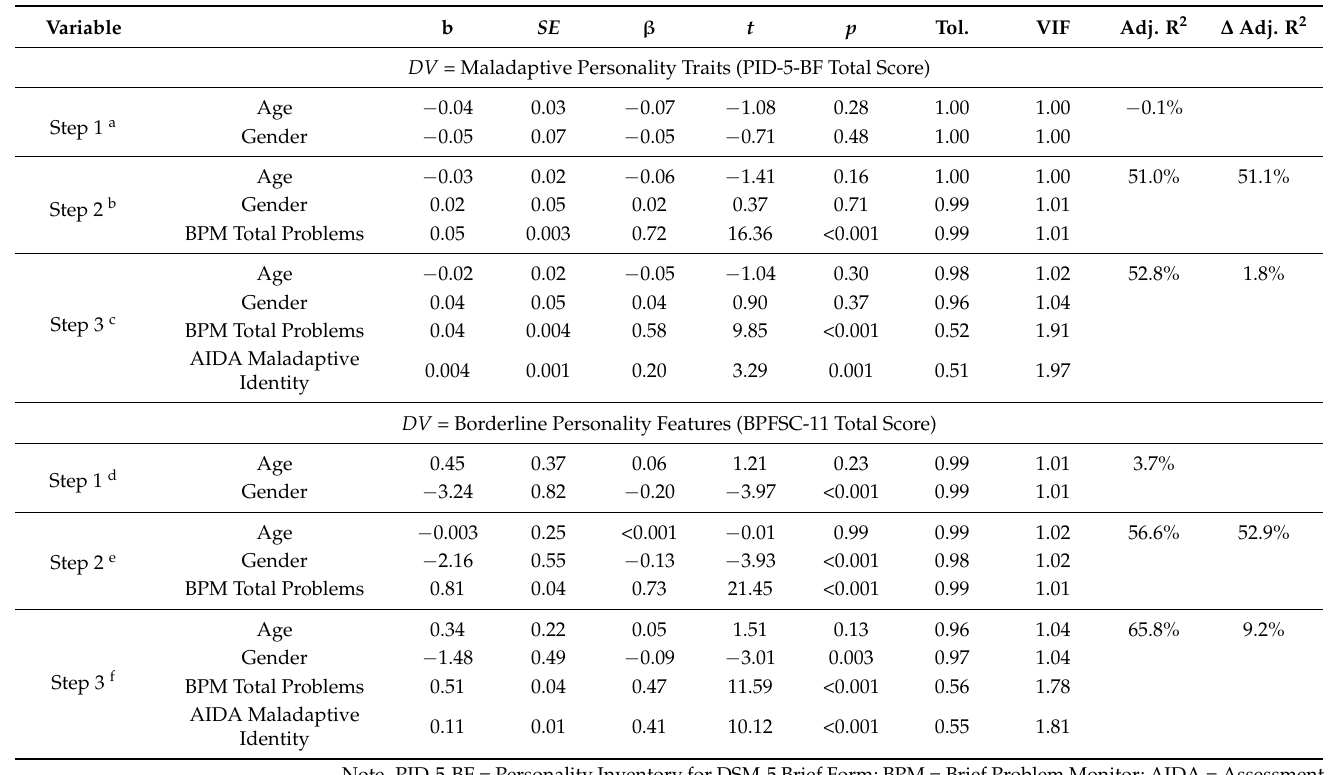
Table 4. Hierarchical regression models testing the incremental validity of AIDA maladaptive